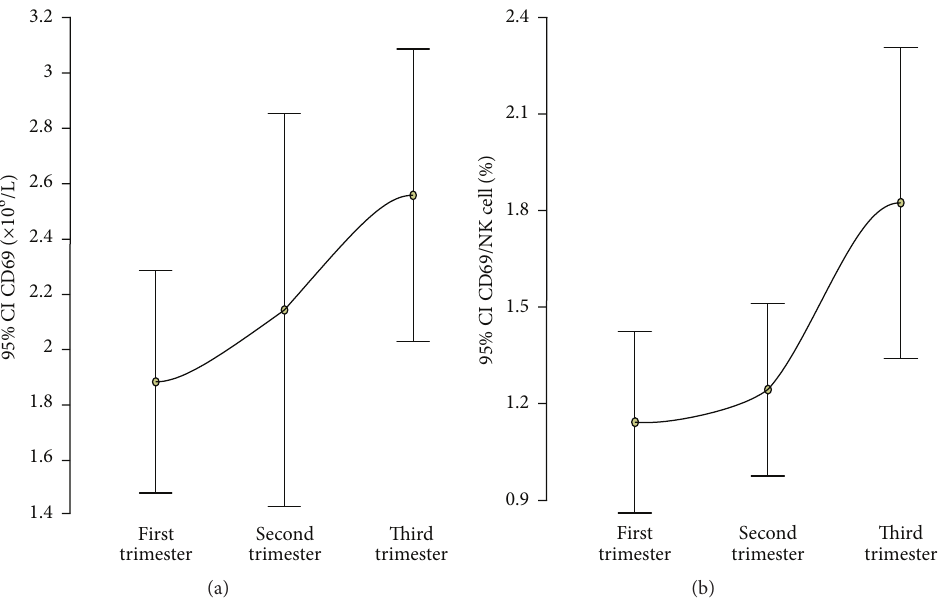
Figure 4: Error bar plots of the mean and 95% confidence interval of CD69 count (a) and CD69/natural killer cell count (%) (b) in each trimester of